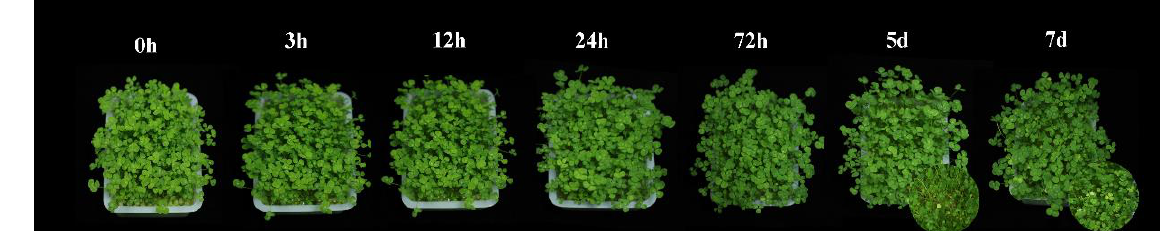
Average leaf Cd concentrations at 0, 3, 12, 24, and 72 h after Cd treatment were 19.82, Figure 1. The phenotypic changes of T. repens from 0 h to 7 d under the Cd stress. 129.95, 202.67, 260.56 and 564.72 mg/kg dry weight (DW), and the average root Cd con-